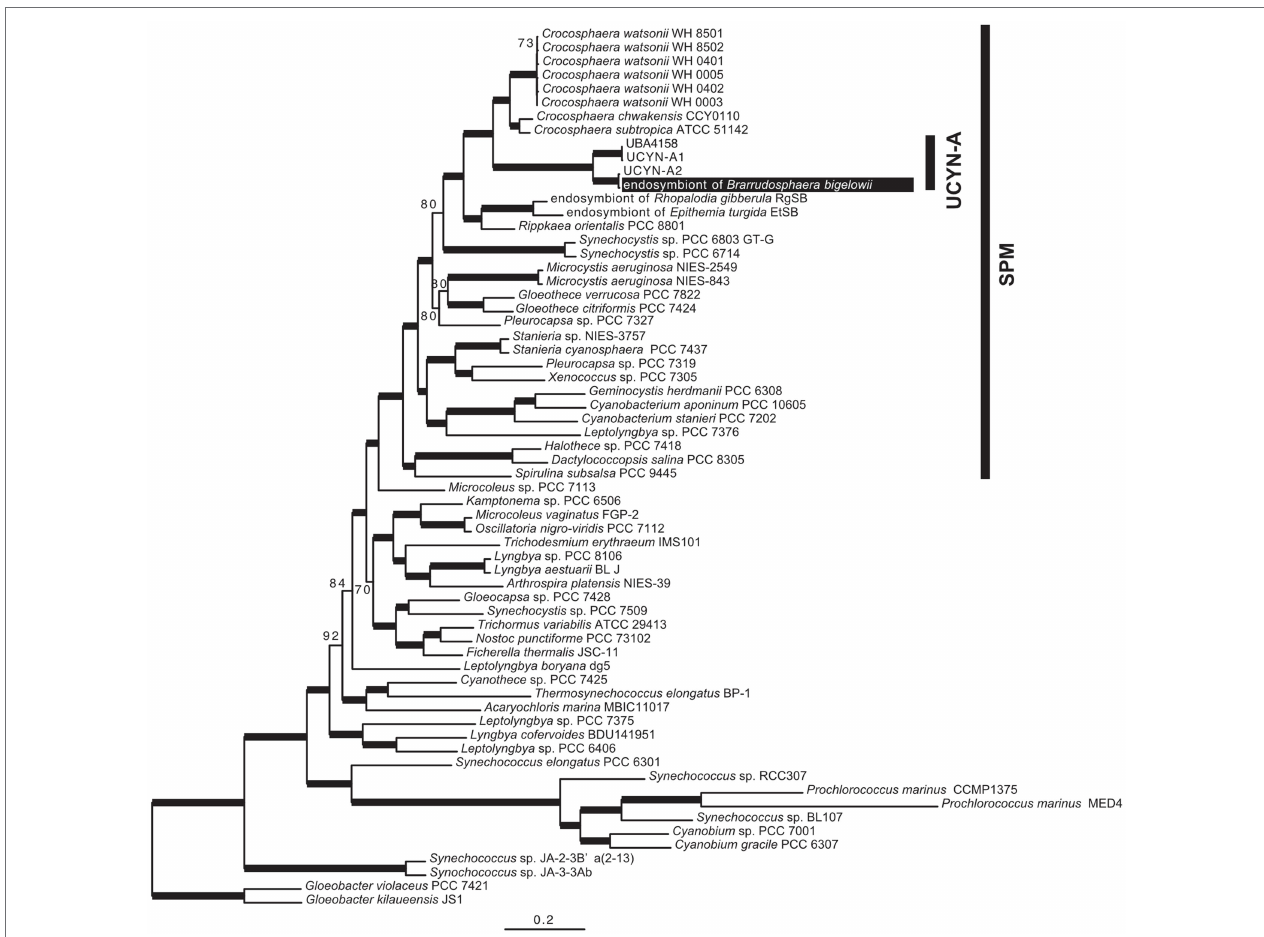
FIGURE 3 | Phylogenetic tree based on the 160 proteins encoded in the genome of the B. bigelowii endosymbiont. The ML tree was inferred using 160 proteins of 64 cyanobacteria (46,587 amino acids). Bootstrap values (BP) are shown on nodes. Bold lines indicate a BP value of